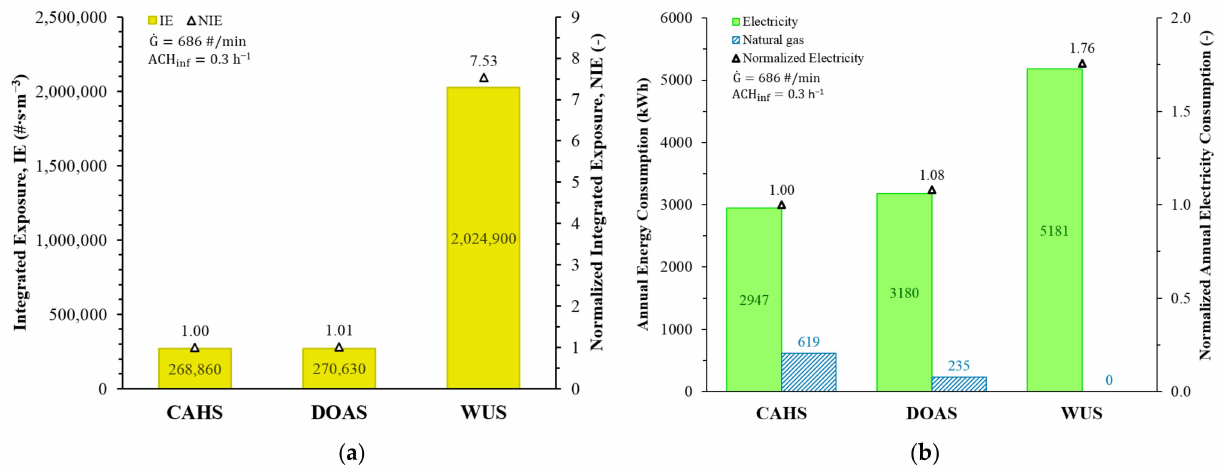
Figure 5. Comparison of base-case: ( a ) IE and NIE of different types of HVAC system considered (Figure 2) for 3 h per day of continuous exposure and virus-laden bioaerosol generation; ( b ) associated energy consumption of HVAC